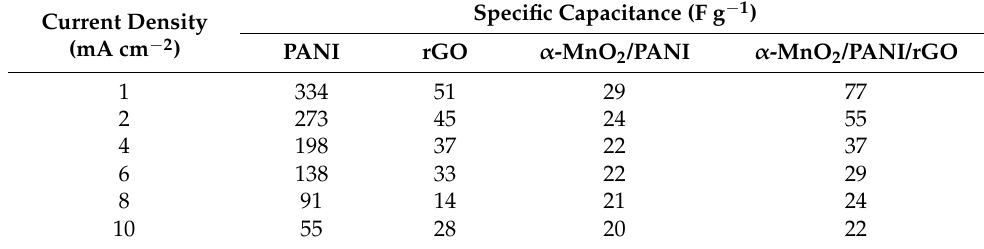
Figure 6. GCD cycles of ( A ) PANI, ( B ) rGO, ( C ) α -MnO 2 /PANI and ( D ) α -MnO 2 /PANI/rGO.